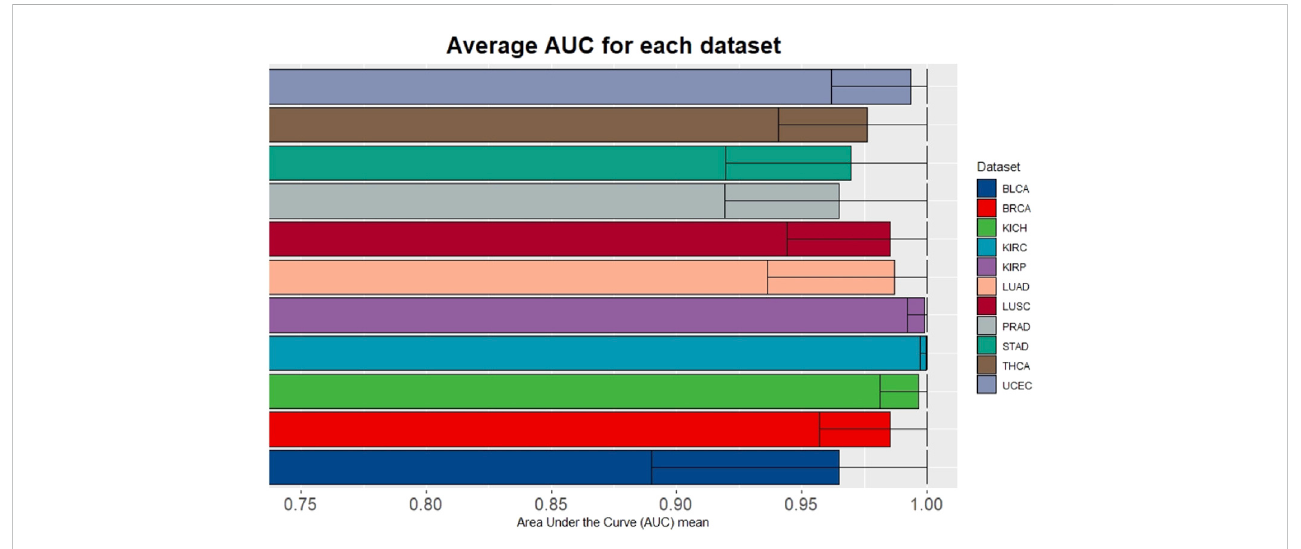
FIGURE 7 Average of AUC over the top 10 signi fi cant groups for all the 11 TCGA datasets.